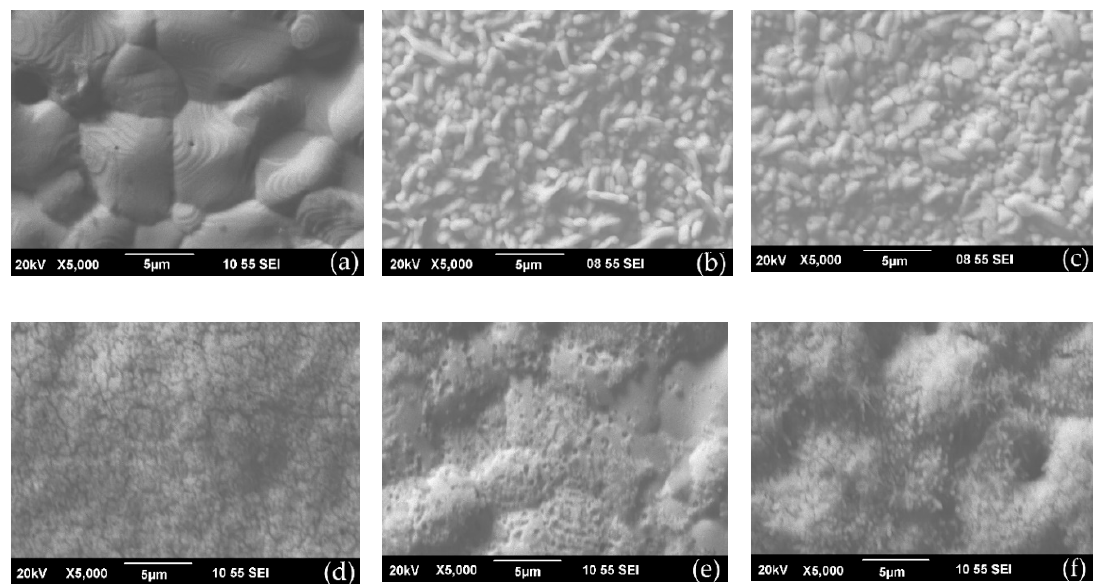
Figure 5. SEM images of surfaces: ( a ) AgSPE, ( b ) Ag/AgCl QRE type 4, ( c ) QRE mix and AgSPEs modified in potentiostatic mode (0.325 V, 120 s) in solutions containing ( d ) 5 mM K 3 [Fe(CN) 6 ], 54.5 mM Na 2 HPO 4 , 12.1 mM KH 2 PO 4 and 1 M KNO 3 , ( e ) 5 mM K 4 [Fe(CN) 6 ], 54.5 mM Na 2 HPO 4 , 12.1 mM KH 2 PO 4 and 1 M KNO 3 , ( f ) 5 mM K 3 [Fe(CN) 6 ], 5 mM K 4 [Fe(CN) 6 ], 54.5 mM Na 2 HPO 4 , 12.1 mM KH 2 PO 4 and 1 M KNO 3 .